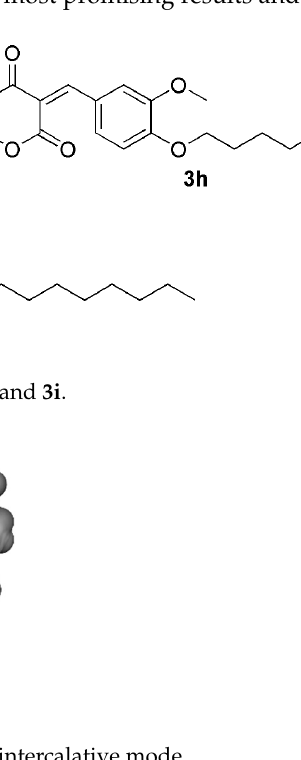
Figure 2. Compound 3i bound to DNA in intercalative mode.